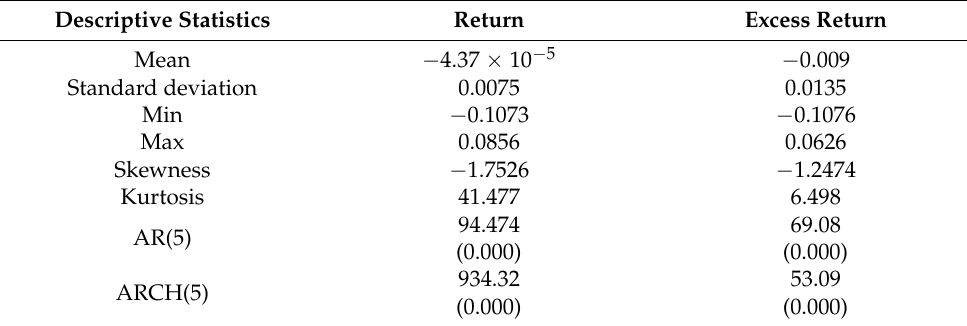
Table 2. Descriptive statistics of CROBEX returns and excess